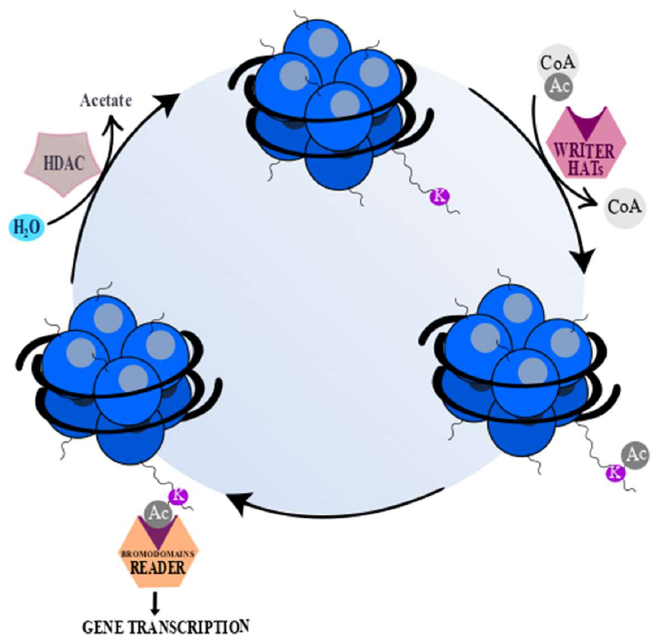
Figure 2. “Writers”, “readers”, and “erasers”. “Writers” (histone acetyltransferases (HATs)) (pink)